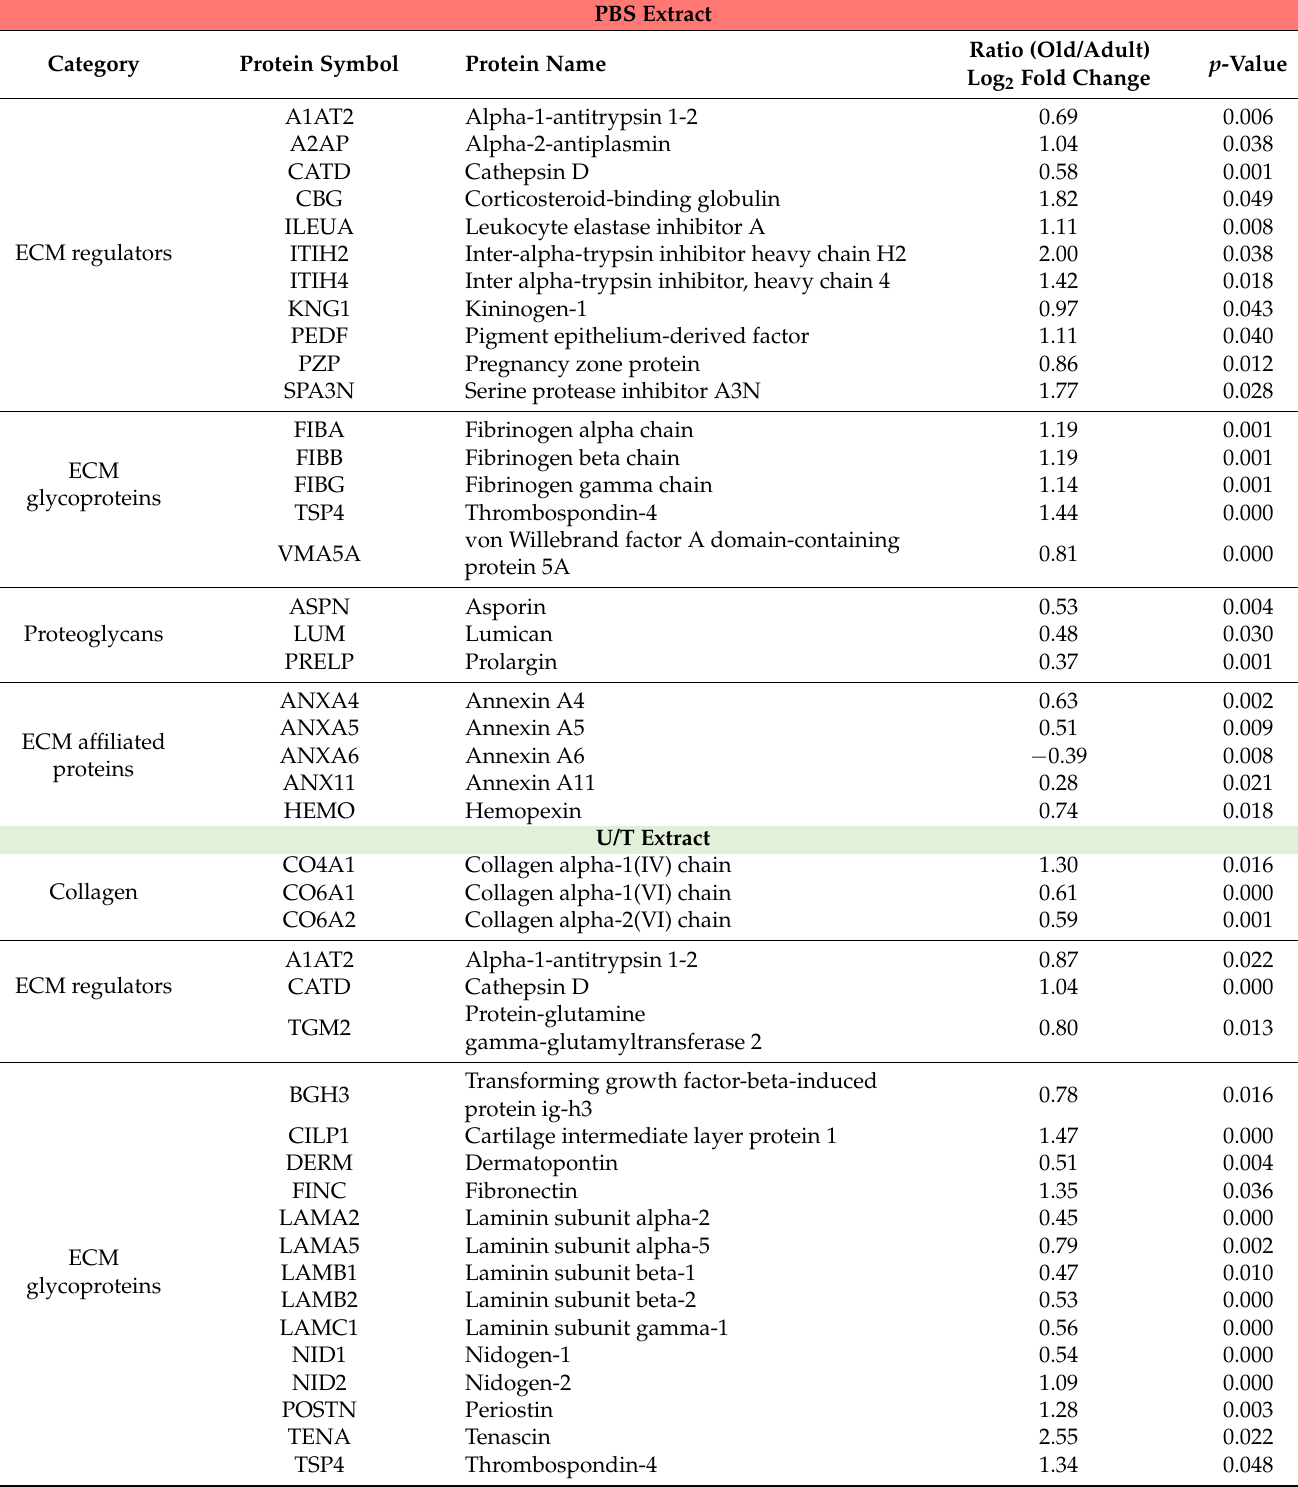
Table 2. List of matrisome proteins whose amount statistically significantly changed in old vs. adult gastrocnemius muscles. Quantification was performed by label-free mass